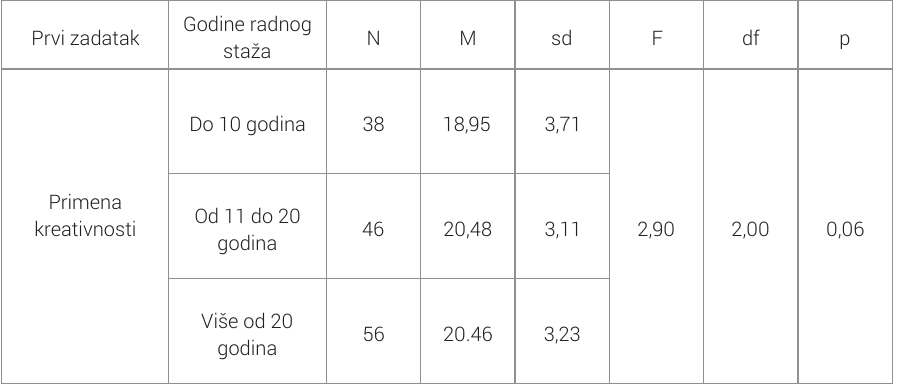
Tabela 3: Primena kreativnosti na časovima Table 3 / Apply creativity to